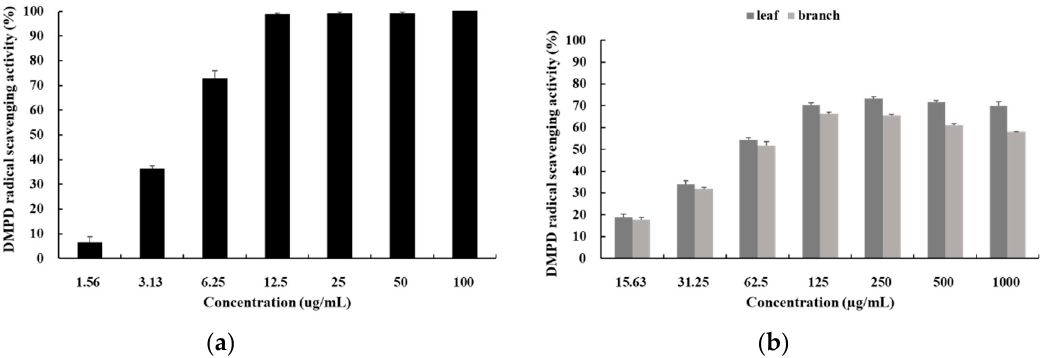
Figure 3. DMPD (dimethyl-4-phenylenediamine) radical scavenging activities of ( a ) L-ascorbic acid and ( b ) hot-water extracts from S. samarangense . An appropriate amount of ascorbic acid was used as a positive control. The results were expressed as the mean ± SD of data obtained from three independent experiments.